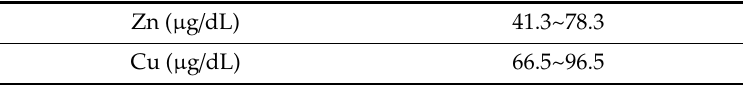
Figure 6. Two points are indicated for a win–win relationship of both zinc and copper in the dialysis group. Safety range of zinc is 41.3–78.3 μ g/dL, and that of copper is 66.5–96.5 μ g/dL. Safety ranges mean causing no deficiency or over shoot in zinc and copper. The recommended safety ranges of zinc and copper in hemodialysis patients are shown in Table 2. Table 2. Recommended Safety Ranges in hemodialysis patients.